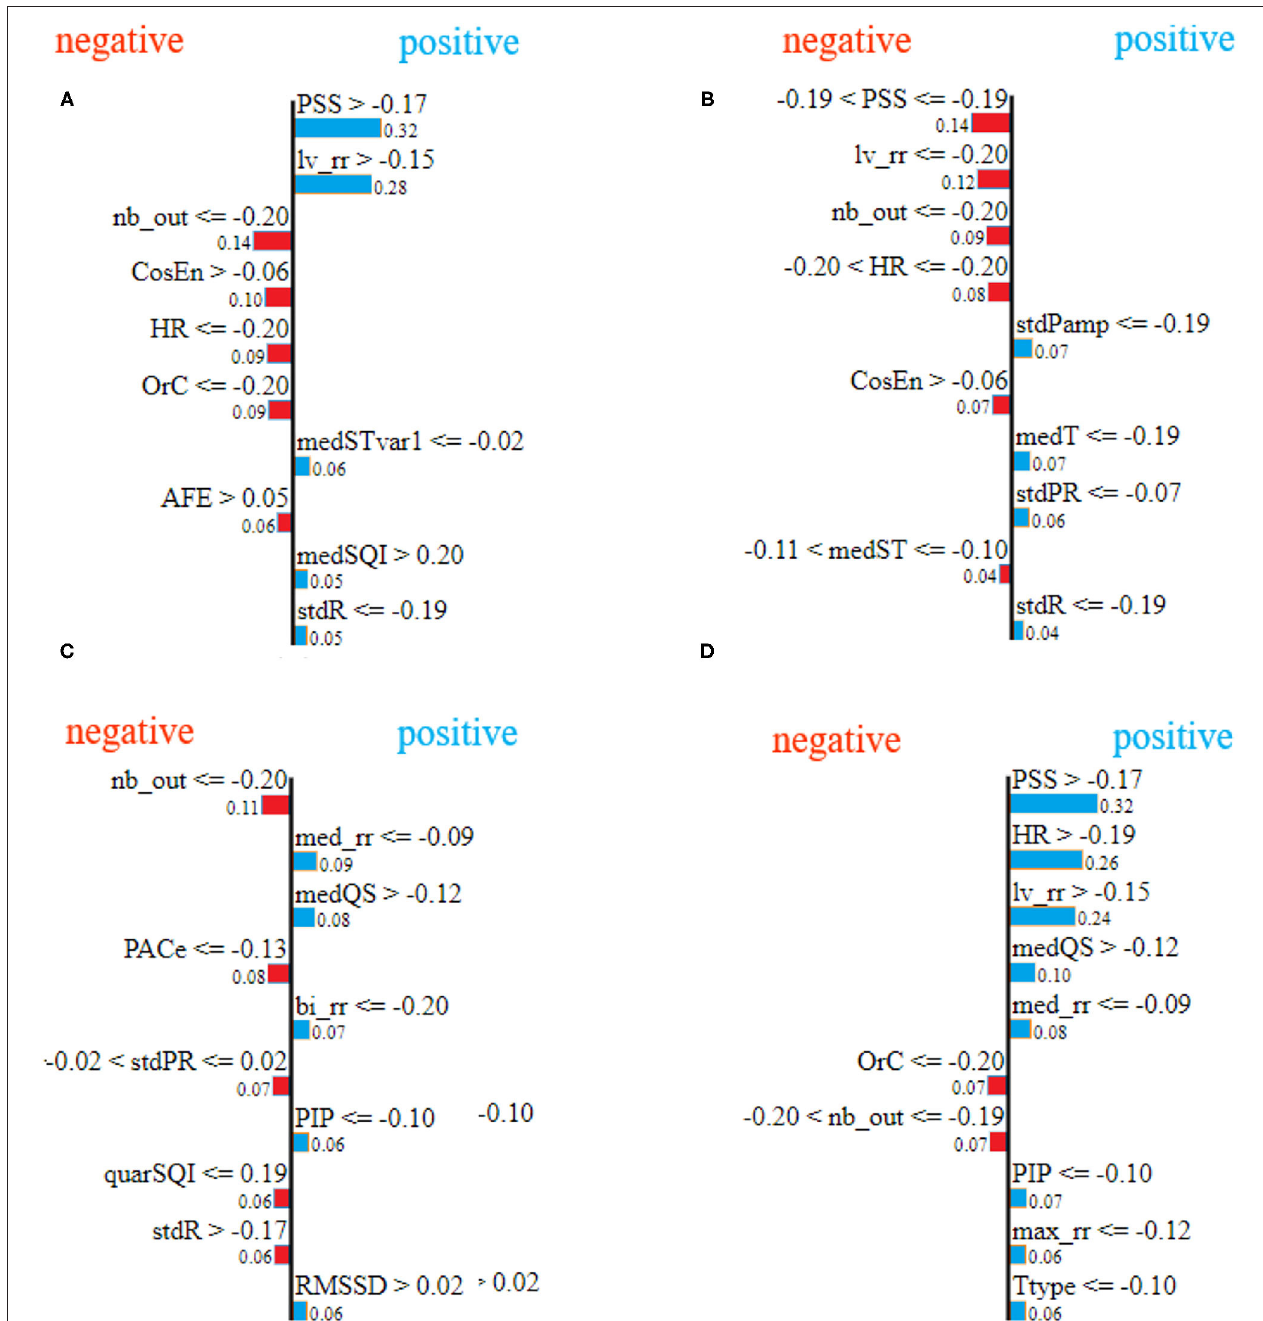
FIGURE 9 | LIME feature importance for different samples, selected randomly from test set, corresponding to class atrial fibrillation (A) , class normal sinus rhythm (B) , class other rhythms (C) , and class noisy recordings (D) , respectively.